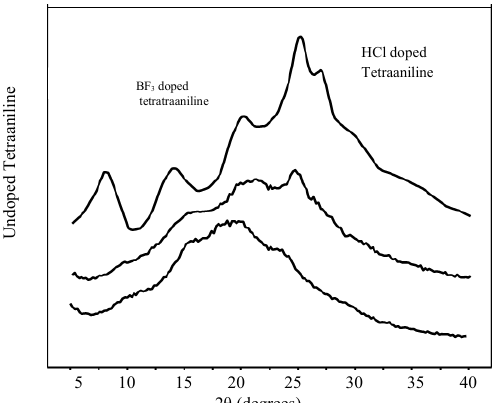
Figure 3. The XRD patterns of undoped, BF3 doped and HCl doped